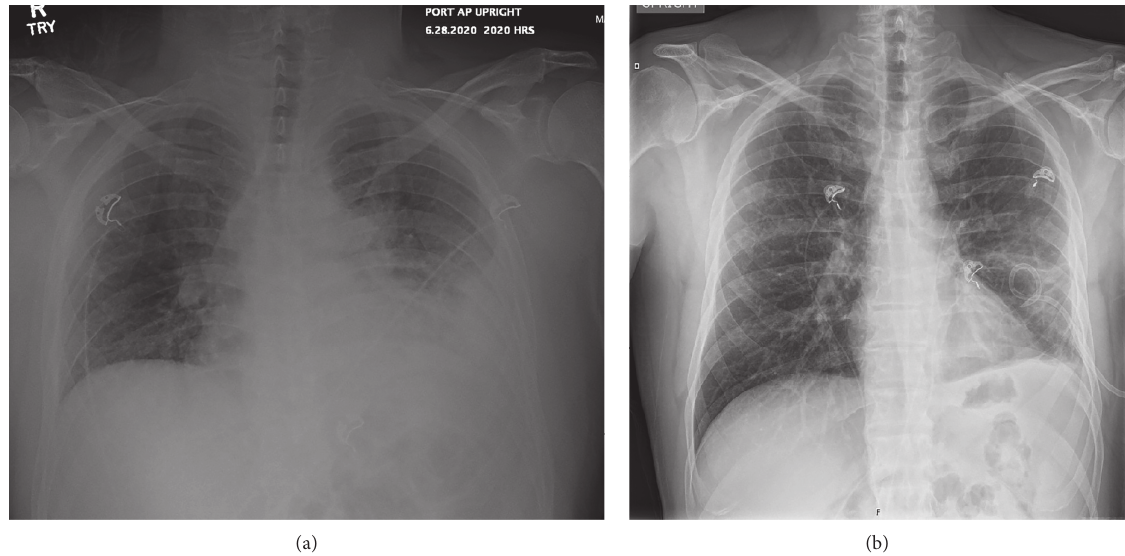
Figure 1: Xray before and after pigtail chest tube placement on second hospitalization.